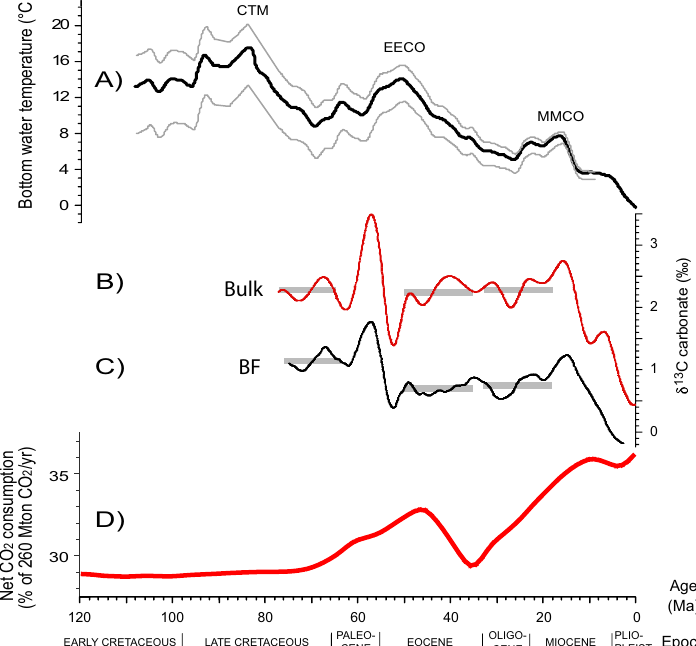
Fig. 8. (A) Bottom water temperatures (Cramer et al., 2011; see caption to Fig. 1 for explanation); (B) δ 13 C carbonate data from whole sediment (Bulk) (smoothed SSA curve from Katz et al., 2005) and (C) δ 13 C carbonate data from benthic foraminifera (BF) from the Pacific (smoothed trend from Cramer et al., 2009), with mean values over selected intervals (77–65, 50–35, 33–18Ma) shown by gray bars in both curves; (D) Secular change in net (one-half of total) CO 2 consumption rate from silicate weathering of all land masses in equatorial humid belt (5 ◦ S–5 ◦ N) (smoothed curve from Fig. 7) expressed as percentage of the present-day global volcanic CO 2 emission rate of 260MtCO 2 yr − 1 (Gerlach, 2011; Marty and Tolstikhin,